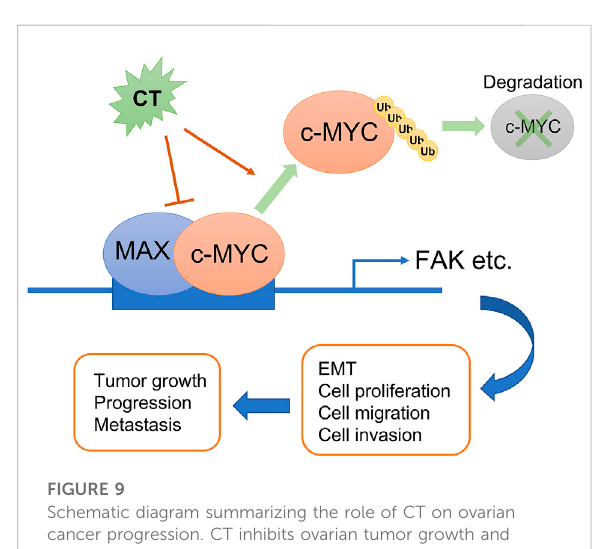
Schematic diagram summarizing the role of CT on ovarian cancer progression. CT inhibits ovarian tumor growth and metastasis via degradation of c-Myc by disrupting its stability and attenuating the FAK signaling